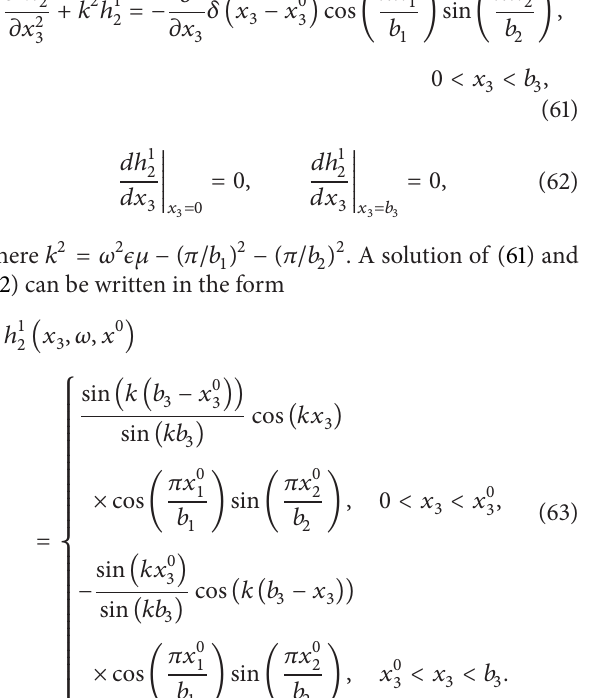
Figure 1: The graphs of ℎ 1 2 and ℎ 1,𝑁 2 for 𝑁 = 15 , 𝑥 0 1 = 2 , 𝑥 0 2 = 3 , and 𝑥 0